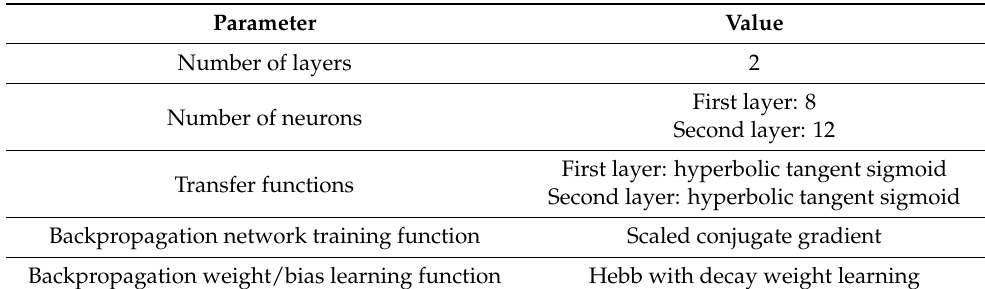
Table 3. Parameters used in the multilayer perceptron neural network for the selection of the most effective color